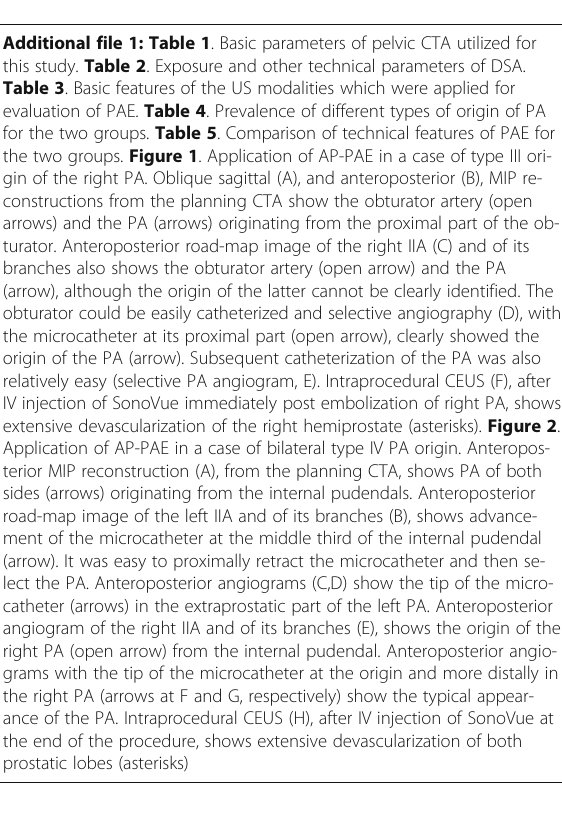
Abbreviations AP: Anteroposterior; BMI: Body mass index; CEUS: Contrast-enhanced ultrasonography; CTA: Computed tomographic angiography; DSA: Digital subtraction angiography; IBC: Indwelling bladder catheter; IIA: Internal iliac artery; IPSS: International prostate symptom score; IV: Intravenous; LUTS: Lower urinary tract symptoms; MIP: Maximum intensity projection; MRA: Middle rectal artery; PAE: Prostatic artery embolization; PA: Prostatic artery; PV: Prostate volume; PVR: Post void residual; S: